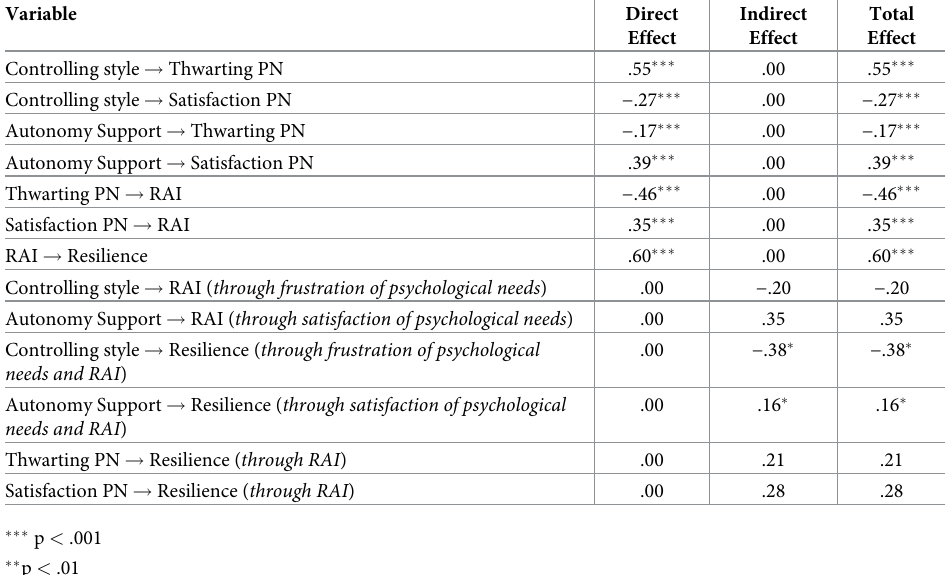
Table 3. Direct, indirect, and total